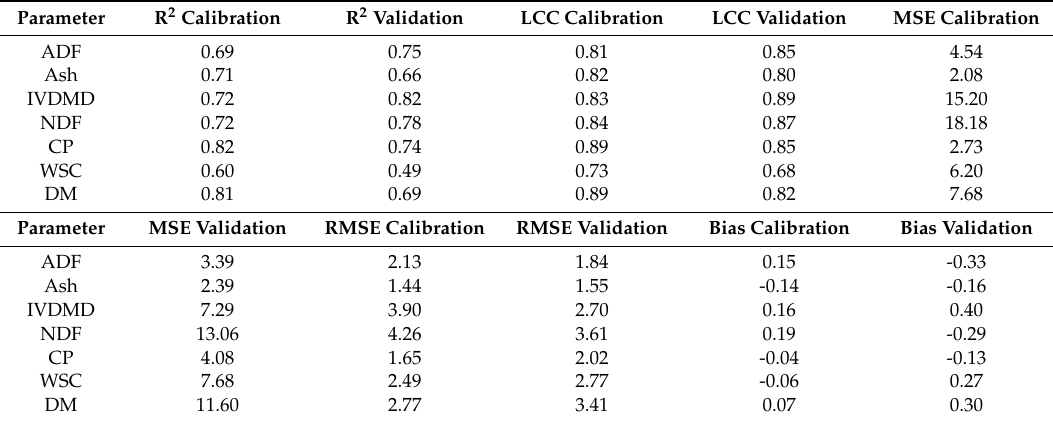
Table 1. The predictive statistics for both the calibration and validation of Cubist models for each nutritive value (NV)